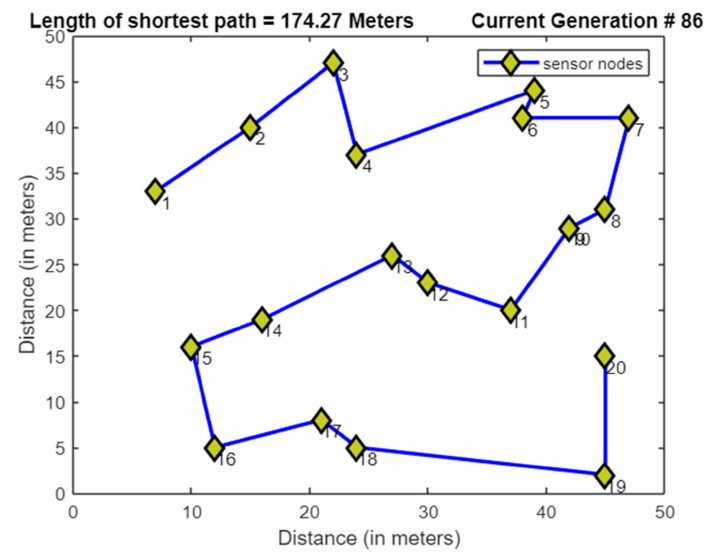
Figure 12. Shortest path obtained by the genetic algorithm (GA). The GA determined the optimal path of length 174.27 m in only 86 generations. The performance of this algorithm can be visualized from the path length versus generations graph shown in Figure